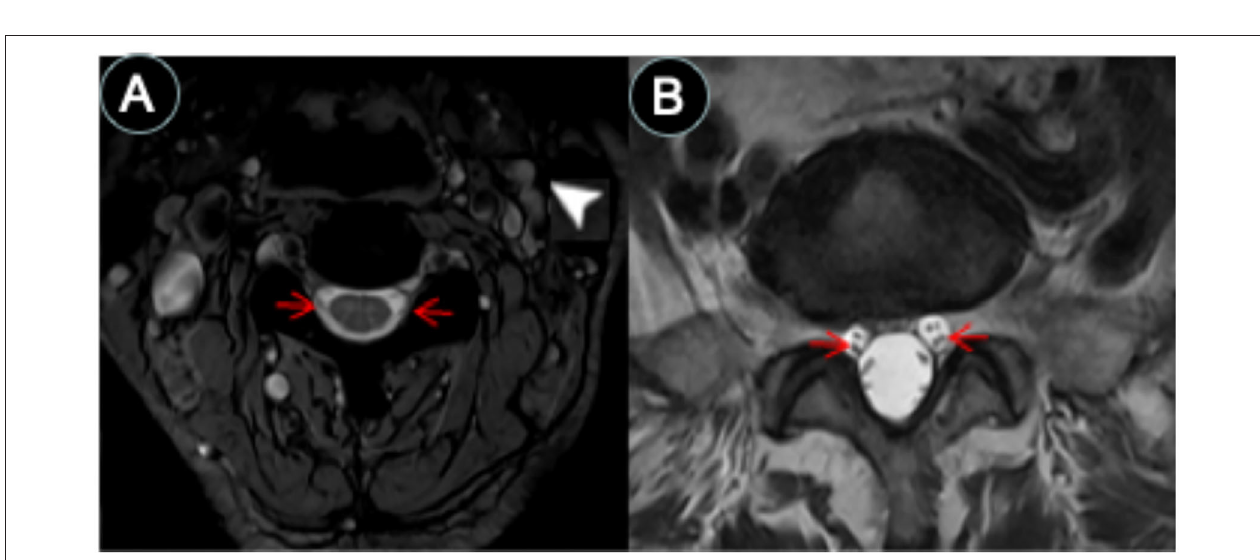
FIGURE 2 | original images, two corresponding magnified images and measurement location); (E) Vagus nerves (CN X) (two original images, two corresponding magnified images and measurement location); (F) Accessory nerves (CN IX) (two original images, two corresponding magnified images and measurement location); (G) Right hypoglossal nerve (CN XII) (two original images, two corresponding magnified images and measurement location); and (H) Left CN XII (two original images, two corresponding magnified images and measurement location). Space between the red and yellow lines: peri-neural space (hyperintense signal). White line: location to measure the diameters of cranial nerves and corresponding peri-neural spaces. All images were generated from the first experiment as described in the method section.